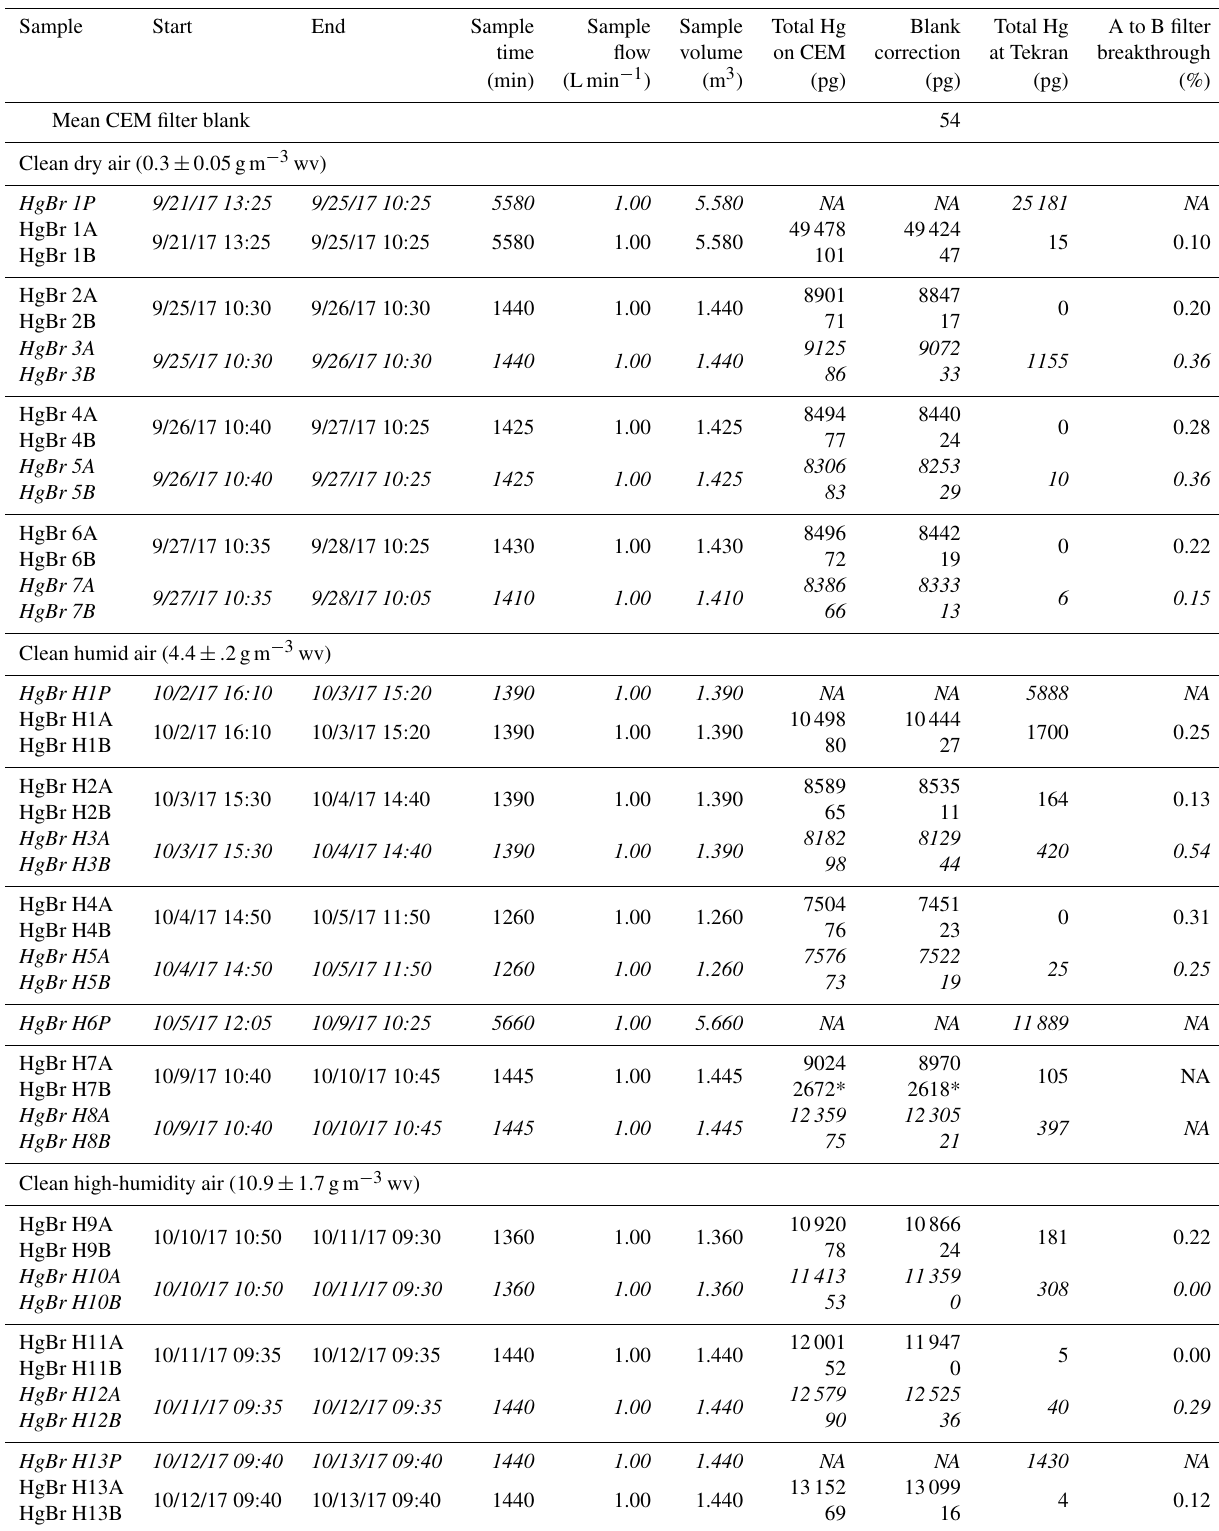
Table 1. Summary of CEM filter loading and breakthrough during HgBr 2 permeations. Samples denoted P indicate approximate permeation rate check through Line 1 via pyrolyzer and Tekran 2537A, italicized text indicates filter deployments on Line 1, and ∗ indicates high values due to a leak around the first filter seal. NA – not